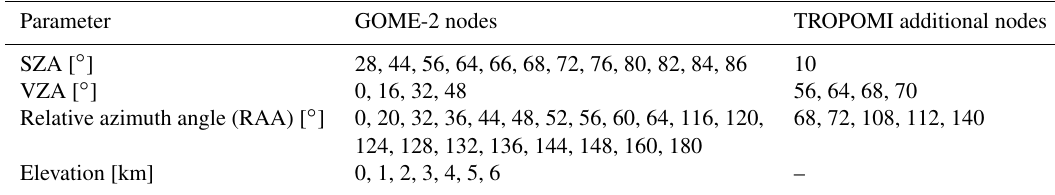
Table A1. Summary of modeled geometries and additional geometry nodes used for